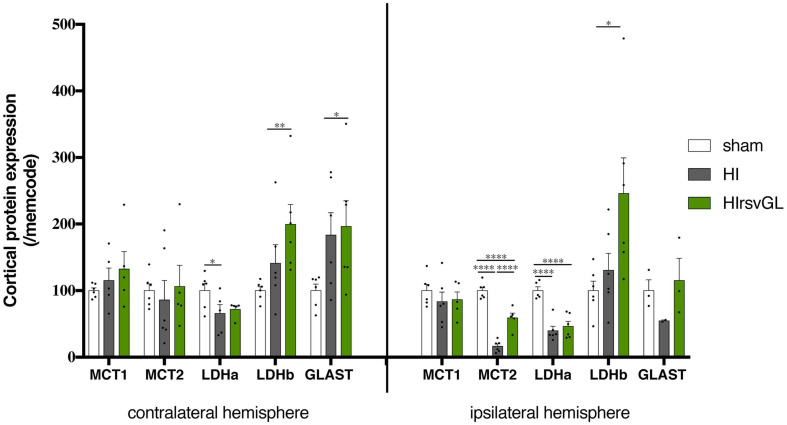
Impact of maternal resveratrol supplementation on expression of key ANLS proteins. Cortical expression levels of MCT1, MCT2, LDHa, LDHb, GLAST, GLT1, and the Na+/K+-ATPase α2 subunit proteins were quantified by Western blots (n = 6 for each group). Quantifications were normalized to Memcode staining. Results are mean values ± SEM and one-way analysis of variance (ANOVA) with Fisher’s LSD post hoc test. ∗: Significant difference between two groups (∗: p < 0.05, ∗∗: p < 0.01, and ****: p < 0.0001).